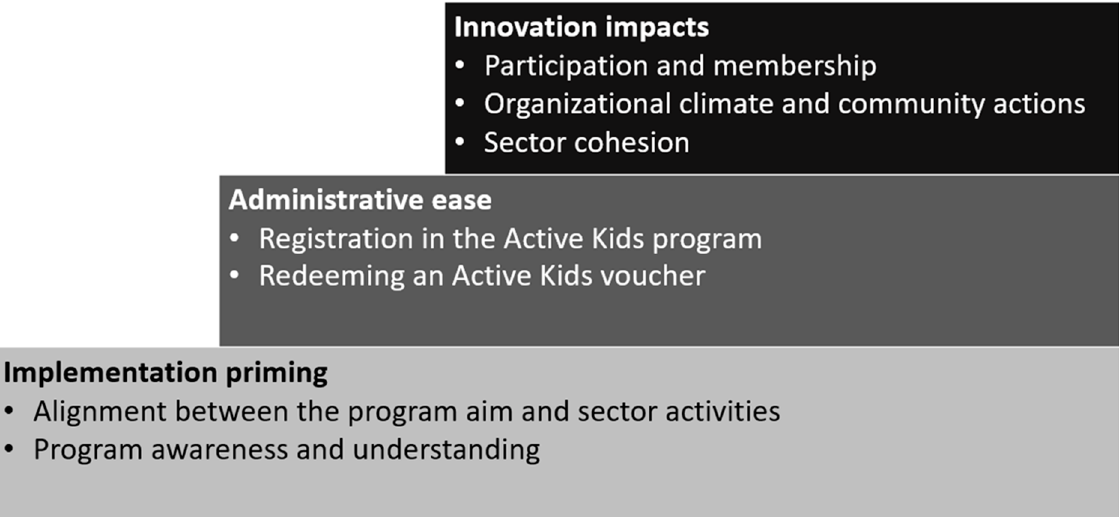
Figure 3. Themes identified through qualitative analysis of interviews with Active Kids providers.